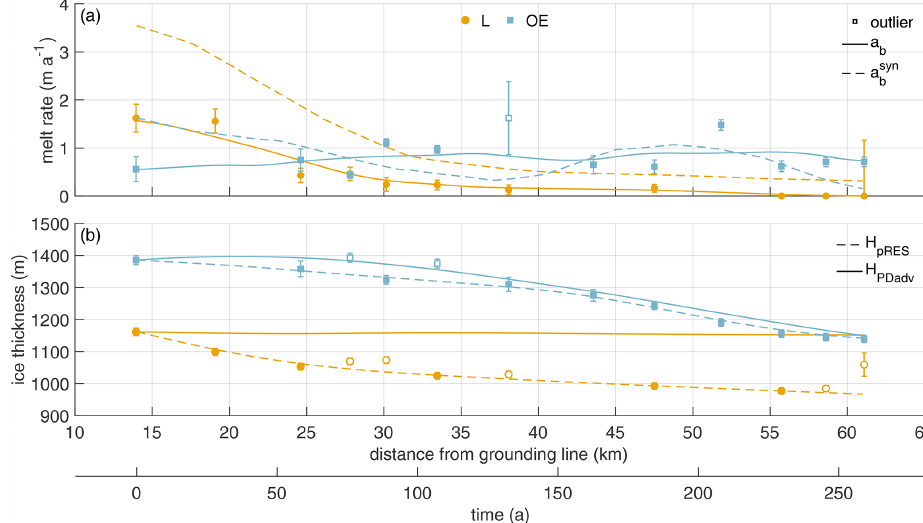
Figure 3. (a) Melt rates at locations L (yellow) and OE (blue) are shown by dots (L) and squares (OE). The interpolated melt rates ( a b ) are shown by solid lines, and synthetic melt rates ( a syn ) that are necessary to reproduce H pRES at L and OE are shown by dashed lines. (b) Ice thicknesses at locations L (yellow) and OE (blue) are shown by dots (L) and squares (OE). The interpolated ice thicknesses ( H pRES ) are shown by dashed lines, and the advected ice thicknesses under present-day climate conditions ( H PDadv ) from the observed melt rates at L and OE are shown by solid lines. The two x axes show the distance from the grounding line in kilometers and the duration of ice flow in years from the measurement location furthest upstream. Unconsidered observations were marked as outliers. Error bars mark the uncertainties of the pRES-derived values.